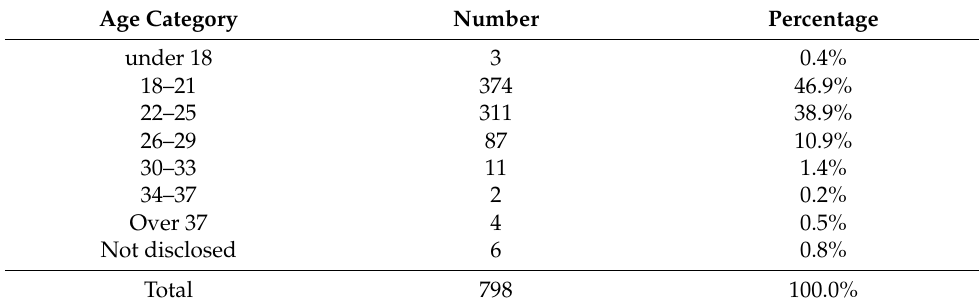
Table 1. Age distribution of participants.